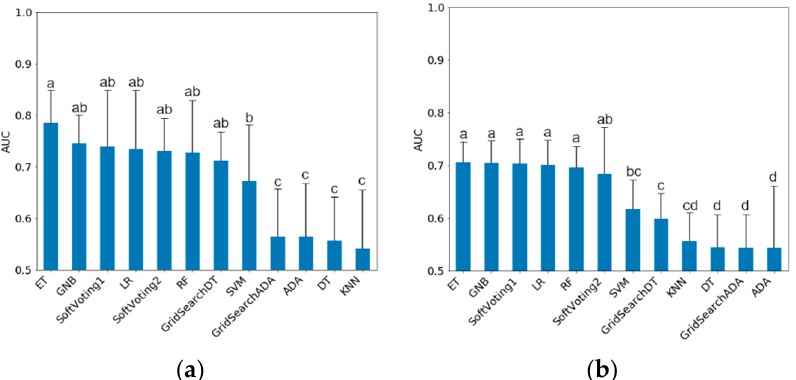
Figure 1. Mean test data AUC (Mean ± CI) for models trained on non-sampled data. ( a ) Mastitis treatments; ( b ) Lameness treatments. Different letters indicate significant ( p < 0.05) differences between classification models. AUC: Area Under ROC-Curve; ET: ExtraTrees Classifier; GNB: Gaussian Naïve Bayes; LR: Logistic Regression; RF: Random Forest; SVM: Support Vector Machine; ADA: AdaBoost; DT: Decision Tree; KNN: K-Nearest Neighbors.